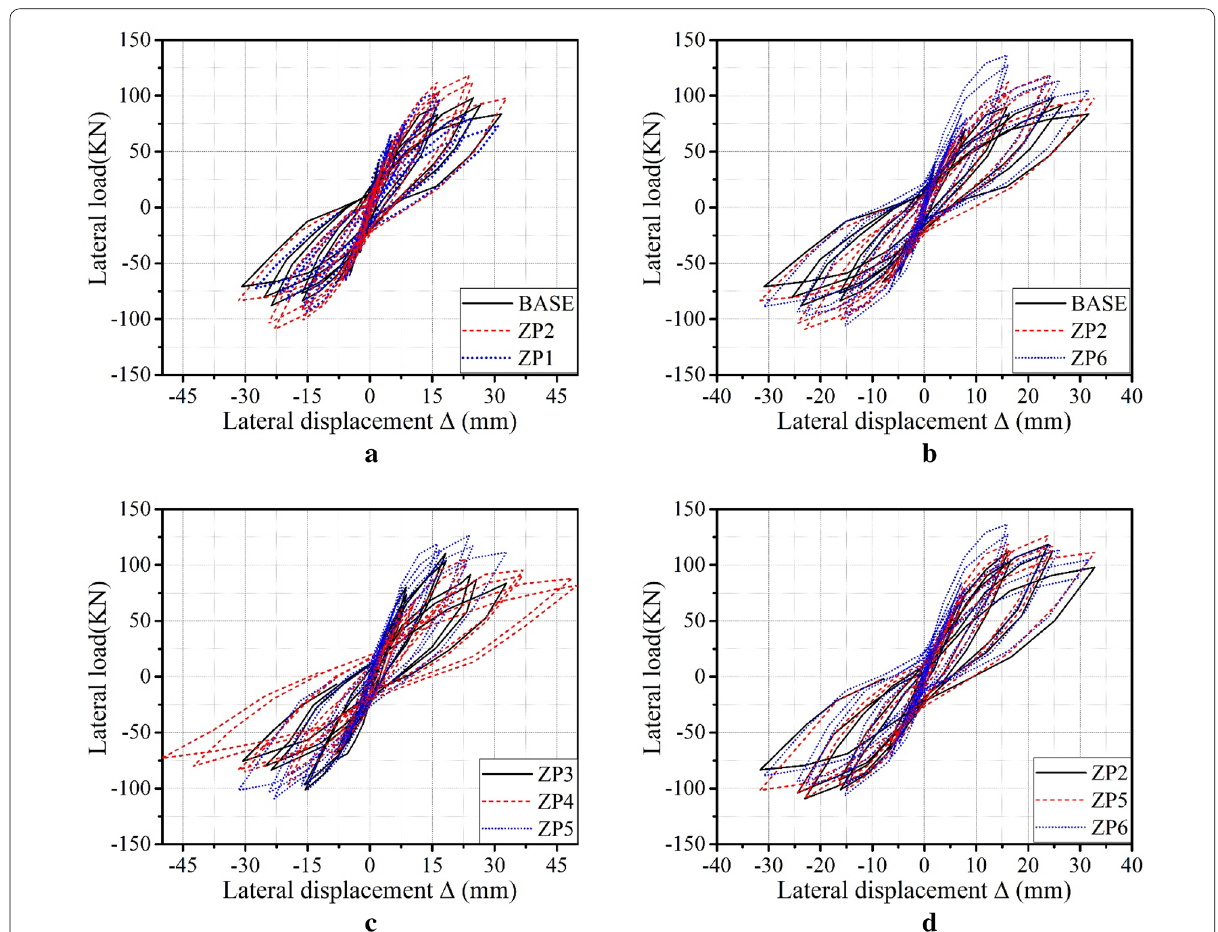
Fig. 7 Load–displacement hysteretic curves of the specimens: a performance of the previous URF connection; b performance of the modified URF connection; c effect of different welding methods; d performance of the 15d weld case.